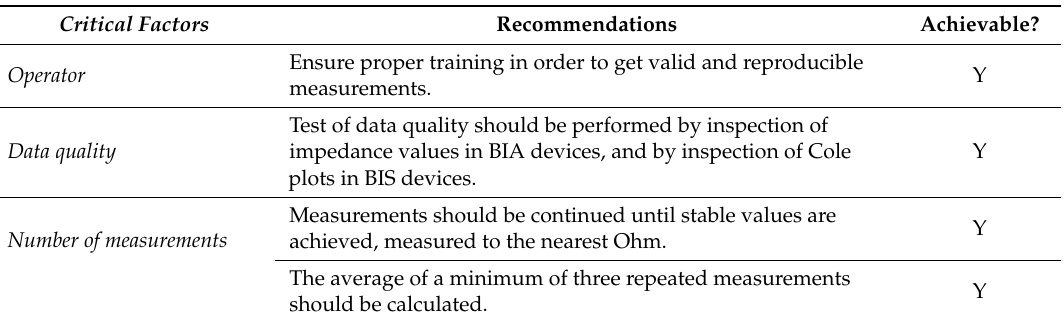
Table 2. Critical factors of bioelectrical impedance analysis in children: are they achievable in infancy? Modified from Brantlov et al.